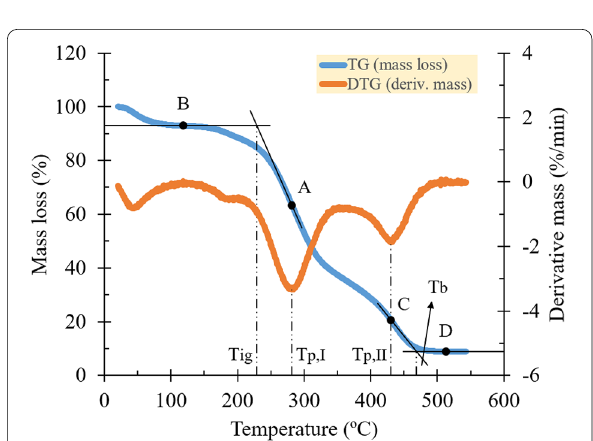
Fig. 2 Schematic for determining the peak, ignition, and burnout temperatures (e.g., at a heating rate of 5 ºC/min; 1st iteration